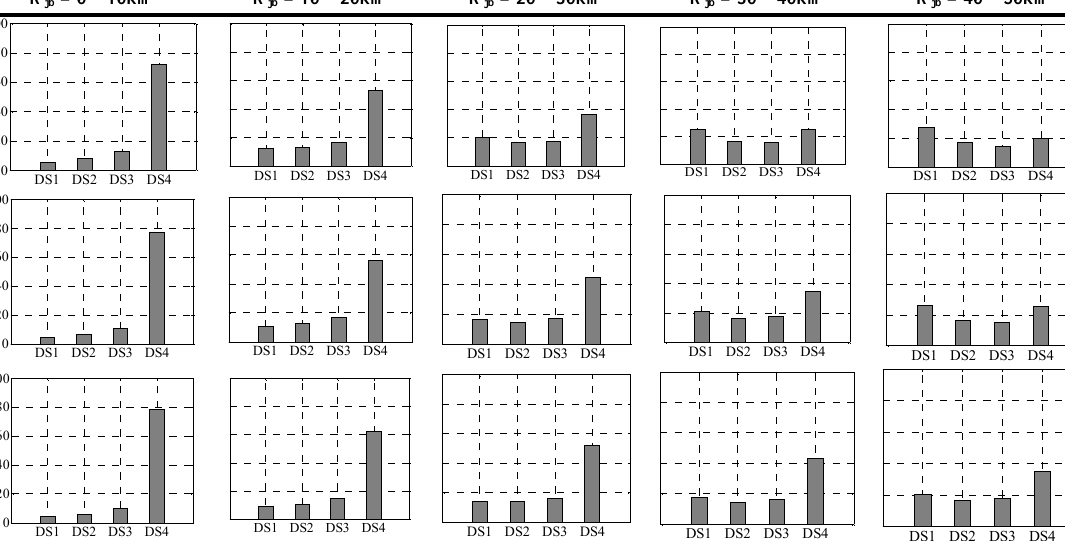
Figure 14 Damageability (percentage of total stock) of DS masonry structures in scenario earthquakes. DS1 represents slight damages; DS2 represents moderate damages; DS3 represents heavy damages; DS4 represents near-collapse/collapse limit state.